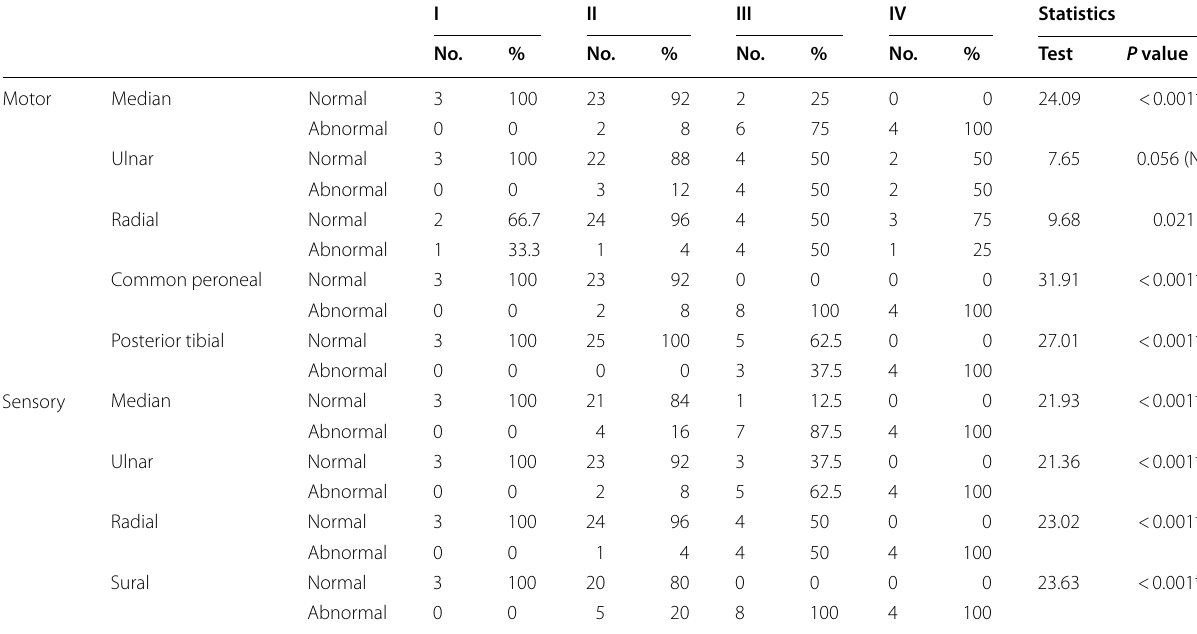
Table 6 Correlation between COPD severity and nerve